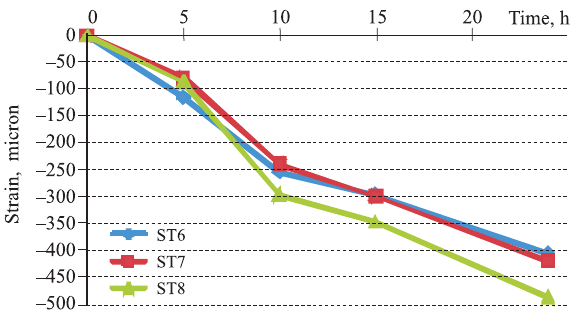
Fig. 13. Effect of scour depth on piles strain